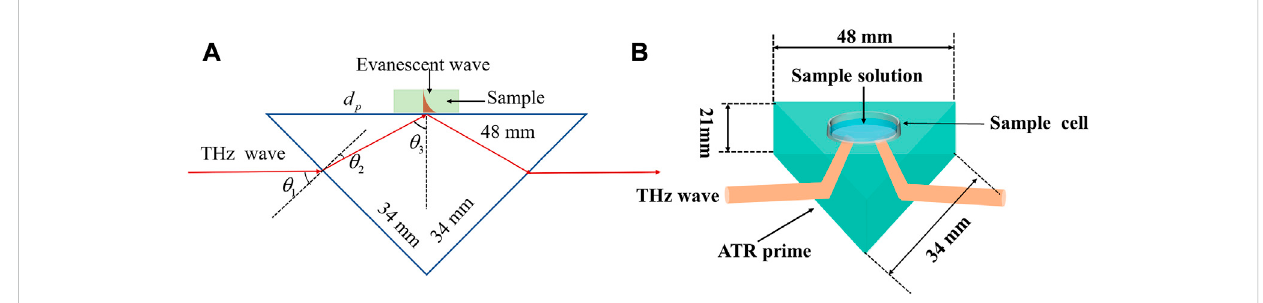
FIGURE 1 The schematic diagram of (A) the design dimensions of the ATR prism and (B) THz-ATR spectroscopic detection of aqueous samples.